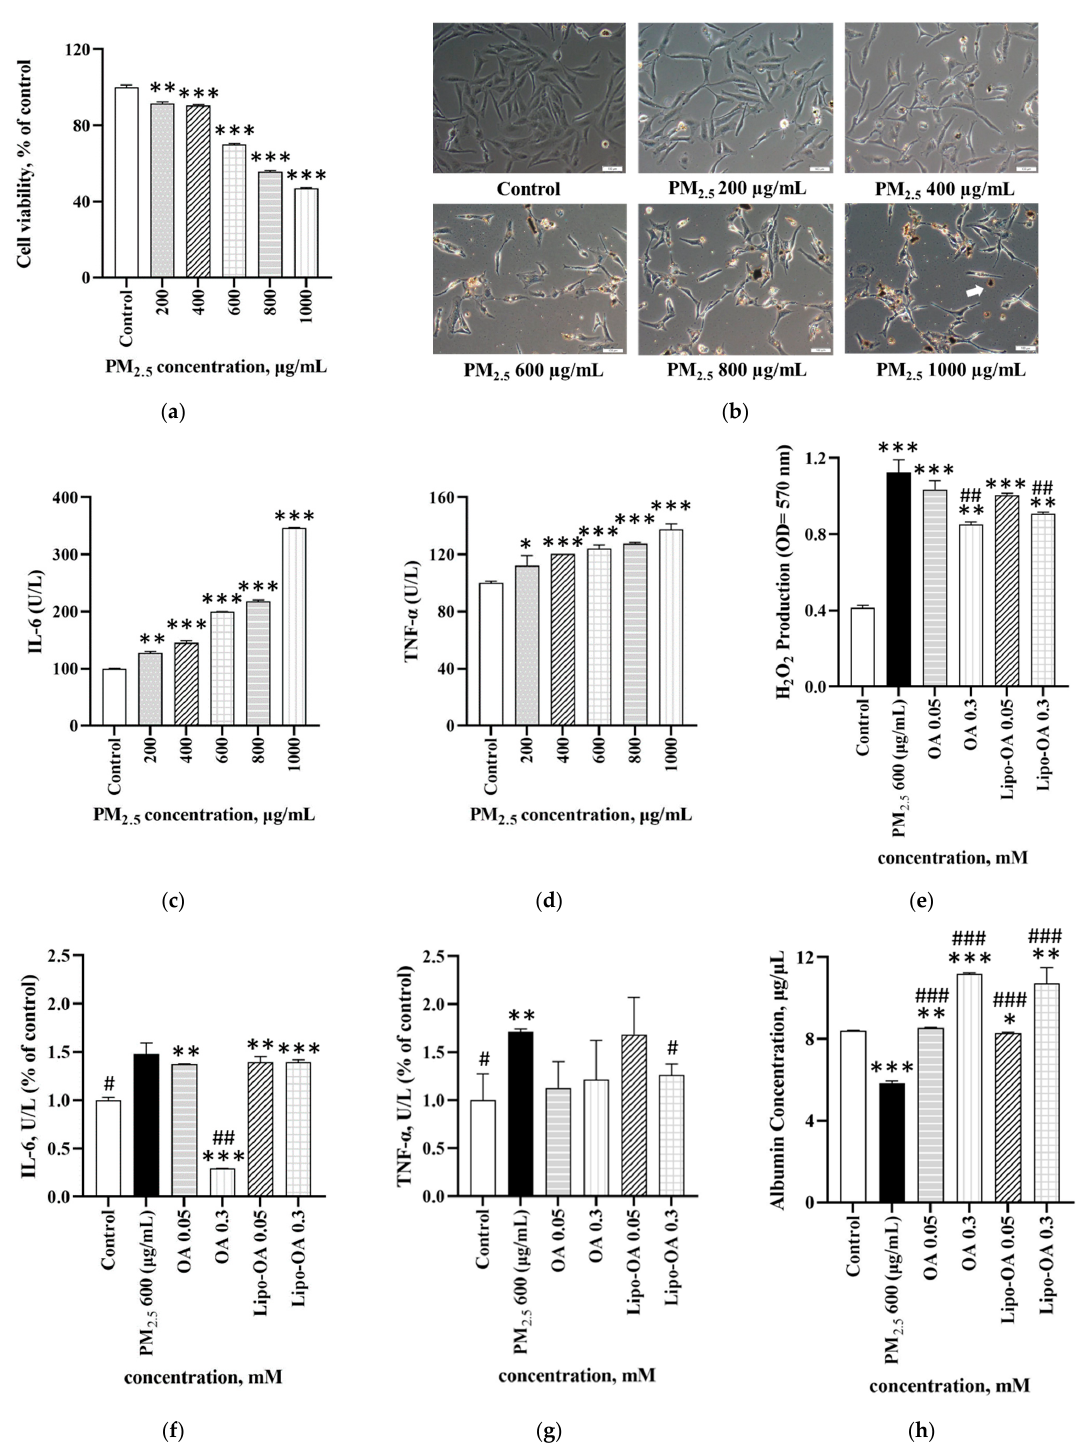
Figure 4. ( a ) MTT assay for PM 2.5 cytotoxicity; ( b ) Images of LX-2 cells treated with PM 2.5 at various concentrations (bar: 200 µ m); ( c ) IL-6; and ( d ) TNF- α response of LX-2 cells treated with PM 2.5 at various concentrations; ( e ) Assessment of H 2 O 2 scavenging activity; ( f ) IL-6; and ( g ) TNF- α response; and ( h ) Albumin secretion by LX-2 cells with PM 2.5 -induced inflammation after treatment with OA and Lipo-OAs at various concentrations. * p < 0.05, ** p < 0.01, *** p < 0.001 compared with control group; # p < 0.05, ## p < 0.01, ### p < 0.001 compared with PM 2.5 600 µ g/mL